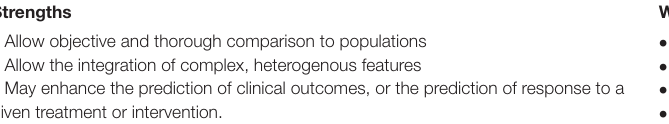
TABLE 1 | SWOT analysis—status interpretation and decision-making.